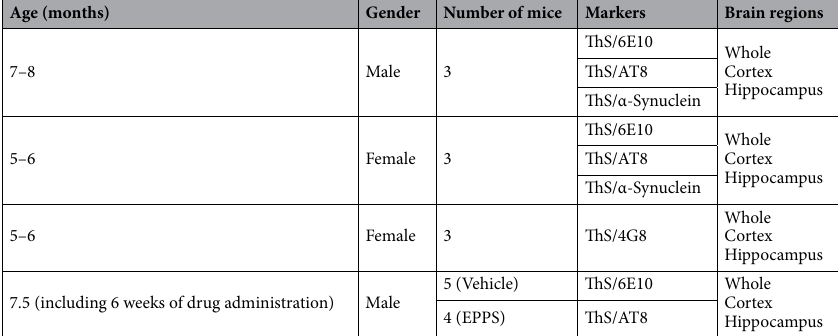
Table 1. Mice preparation for histochemical analyses and drug